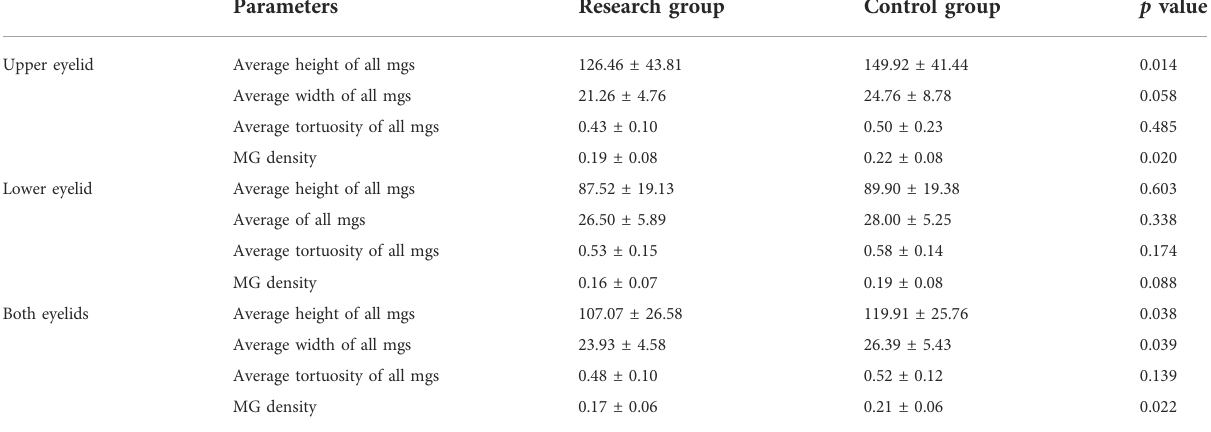
TABLE 3 MG parameters of the two study groups.